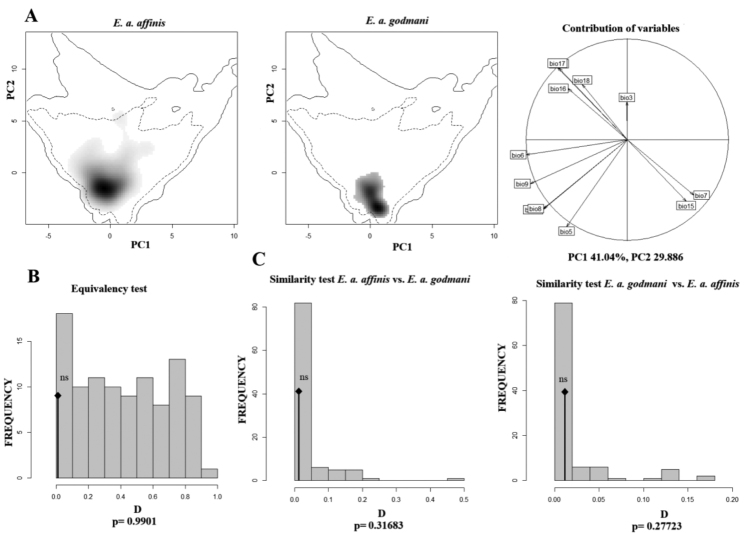
Equivalence and similarity tests in environmental space for E.
a.
affinis and E.
a.
godmani. A PCA of Ecological niche for of E.
affinis lineages and the variables contribution to the analyses. The gray gradient indicates the density of the occurrences of the lineages, and the dashed and solid line indicates the 50% and 100% of the environmental background B graphical results of the equivalency tests comparing the two lineages. For both tests (equivalence and similarity) we only presented values for the D metrics. For all graphs the D observed values of the overlap niche analyses are present with the black diamond. The p value is showing in each graphic, all of them not significant for these analyses C graphical results of the similarity test comparing the two lineages in both directions (E.
a.
affinis vs. E.
a.
godmani and vice versa), ns = Not significant, p > 0.05.